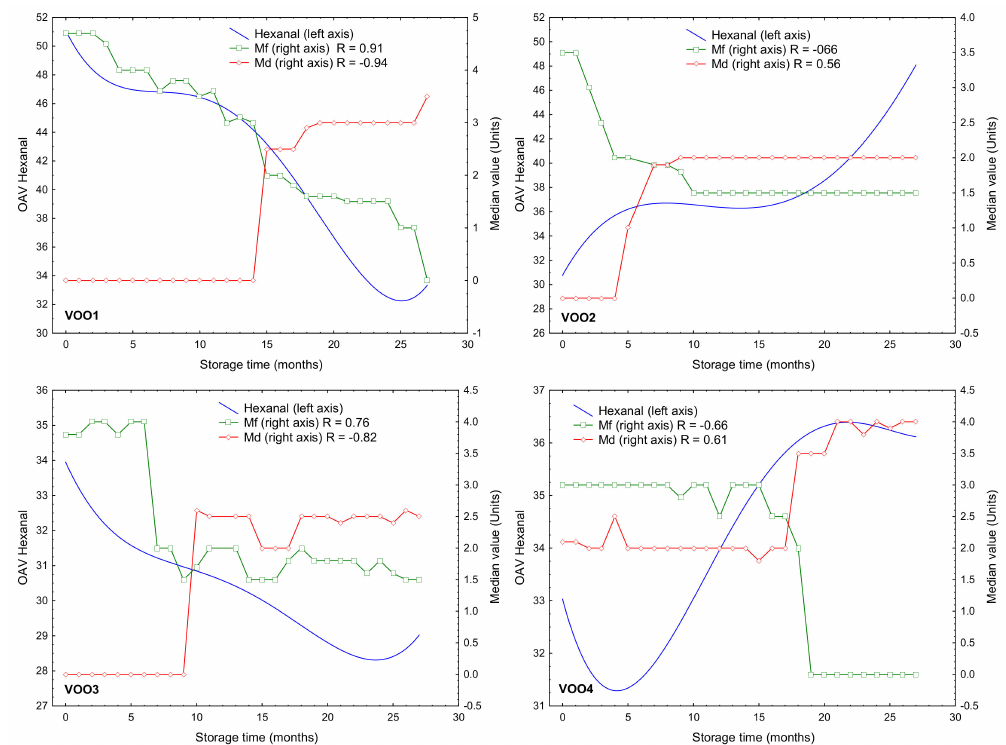
Figure 4. Double-y graph of the median of the fruity attribute (Mf), median of defect (Md) and the OAV (odor activity value) of hexanal for each virgin olive oil (VOO) during the storage experiment. The regression coe ffi cients (R) between Mf and Md in relation to the OAV of hexanal are